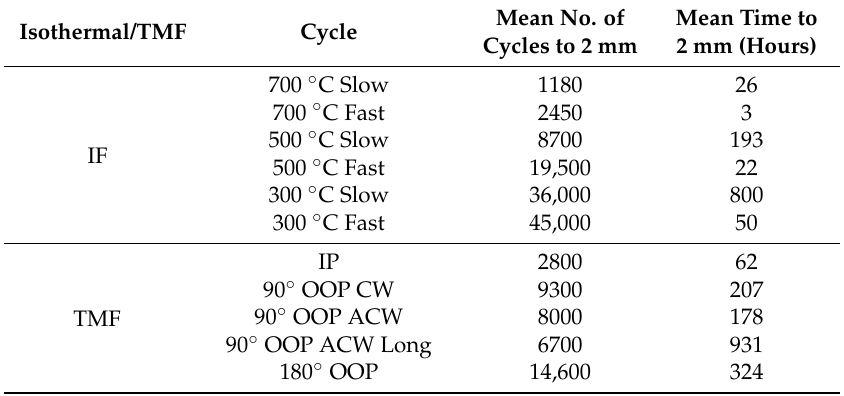
Table 2. Summary of number of cycles to reach 2.2 mm for each test condition.